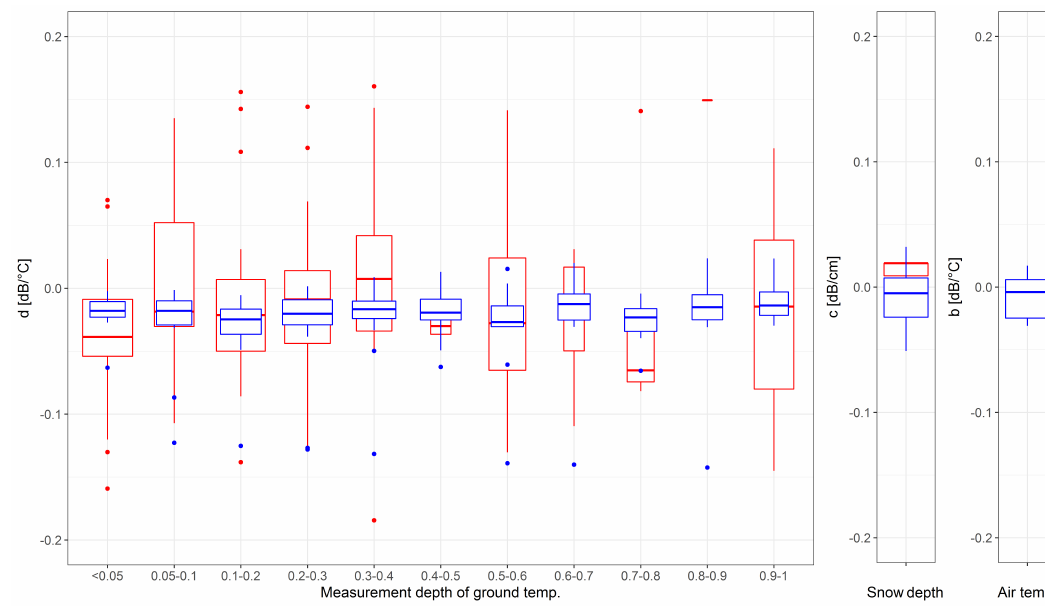
Figure 5. Estimated parameters for ground temperature (grouped for different depths (m)), snow depth and air temperature; red and blue represent study sites with freezing degree days above (blue) and below (red) 4000 degree–days, and the variable width of the boxplots represent the relative number of available data points within one group; outliers are represented by the